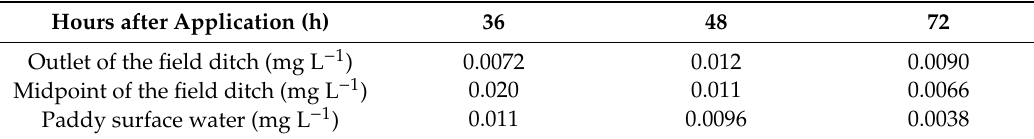
Figure 3. Measured insecticide concentrations at the outlet and midpoint of the field ditch and paddy surface water during or within 24 h after spray applications: ( a ) chlorpyrifos; ( b ) abamectin; ( c ) thiamethoxam. Table 2. Measured chlorpyrifos concentrations at the outlet and midpoint of the field ditch and paddy surface water at 36–72 h after the first spray application.